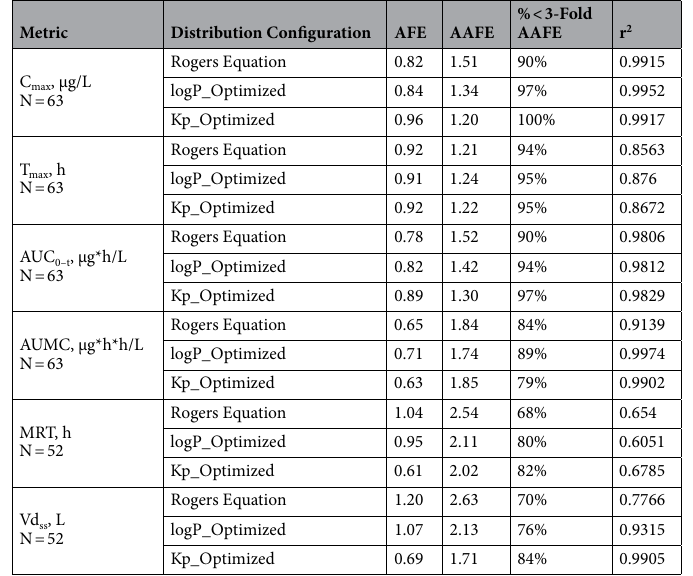
Table 1. Assessment of predicted PK parameter values in subjects across different methodologies for establishing partition coefficients. Compounds without sufficient terminal-phase data were excluded from AUC 0–∞ , MRT, and Vd ss analysis.